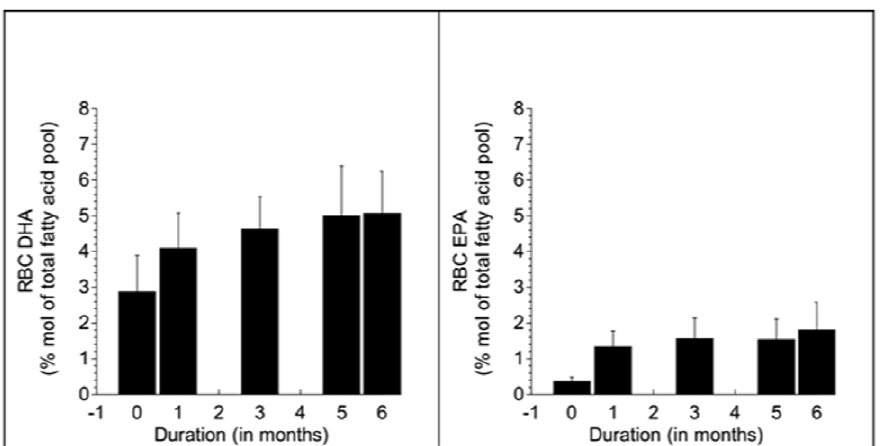
Figure 1. A and B show the increase in RBC DHA and EPA over the course of the six-month study, i.e., from pre-supplementation levels at baseline (0-month) to post-supplementation levels prior to the [11C]DTBZ PET scan (6-months).